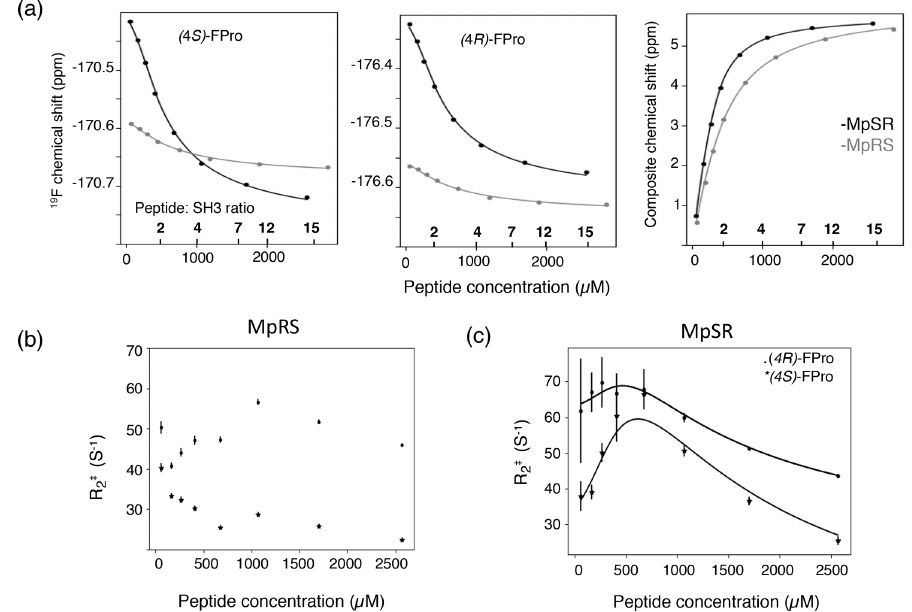
Figure 7. (a) The 19 F chemical shift variation of (4 S )-FPro (left) and (4 R )-FPro (middle) in MpSR (in black) and MpRS (in grey) peptides extracted from 1D 19 F spectra as a function of the total peptide concentrations. The peptide-to-protein ratios are indicated on the top of the axis. Left panel displays the 1 H, 15 N composite chemical shift from 1 H– 15 N HSQC. The experimental data (dots) were fitted simultaneously to derive the equilibrium dissociation constants for the two peptides (solid lines). (b) Variation of the apparent 19 F transverse relaxation rates ( R ‡ ) as a function of MpRS peptide concentrations. (c) Variation of the apparent 19 F transverse relaxation rates ( R ‡ 2 line widths as a function of MpSR peptide concentrations. The black solid lines indicate the expected variation resulting from the fit of the experimental rates with Eqs. (1) and (2) using the transverse relaxation rates of the bound and free peptides ( R b k on as adjustable